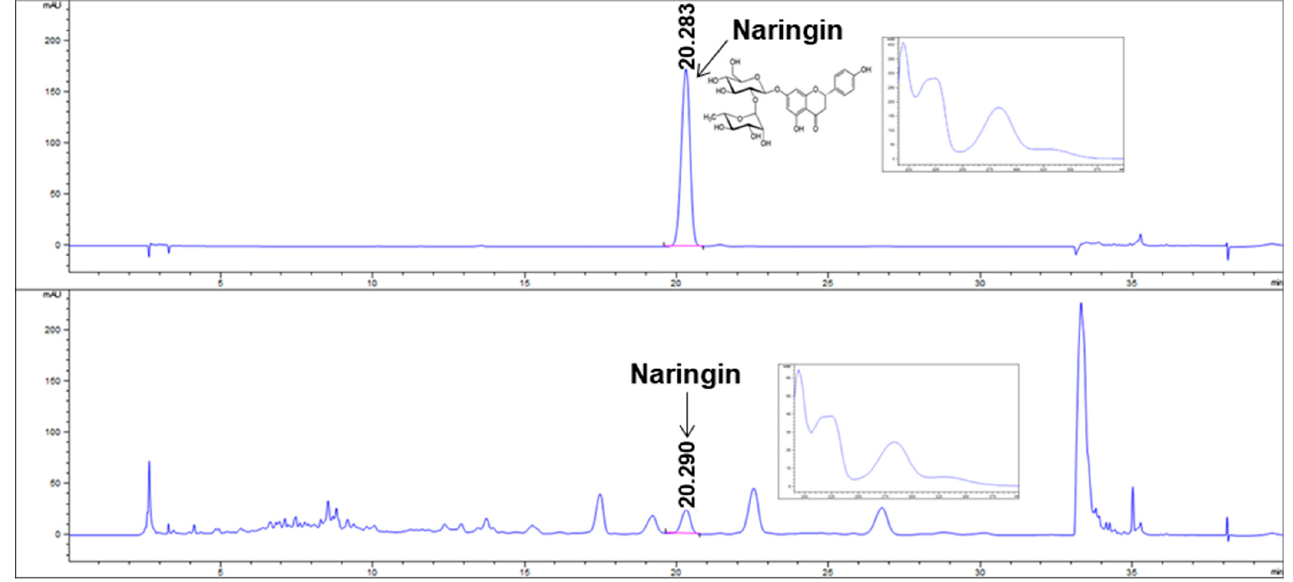
Figure 1. HPLC analysis of naringin and B215. Representative image of HPLC chromatogram at 280 nm of naringin ( upper ) and B215 ( lower ).